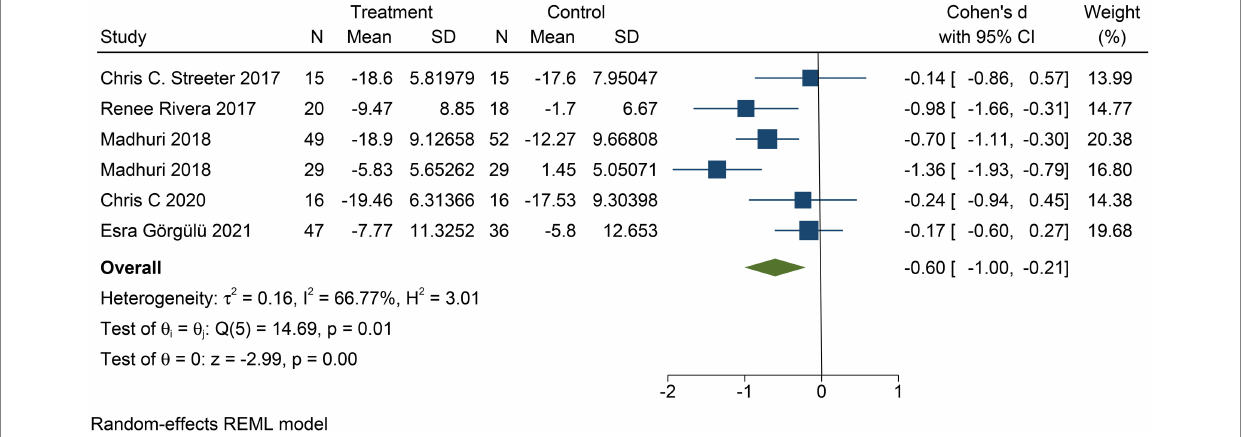
FIGURE 4 Forest plot of BDI-II.